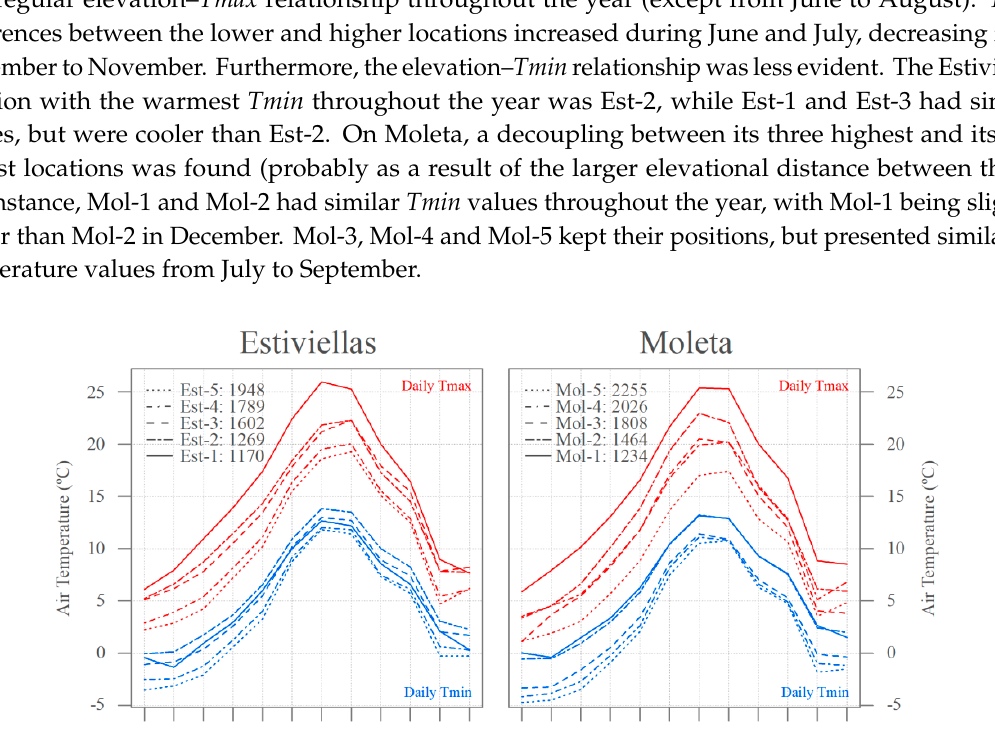
Figure 3. Mean daily maximum ( Tmax ), minimum ( Tmin ) and average ( Tavg ) air temperatures in the ten locations during the study period.